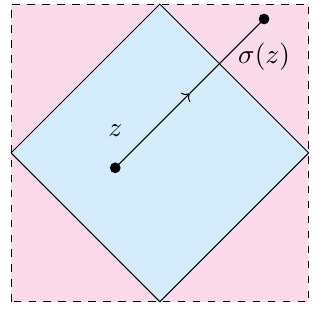
Figure 1 . Contour for light transform extending to the next Poincaré patch. The celestial torus is constructed by identifying along the dashed lines. σ ( z ) denotes the point antipodal to z , having suppressed ε, ¯ z